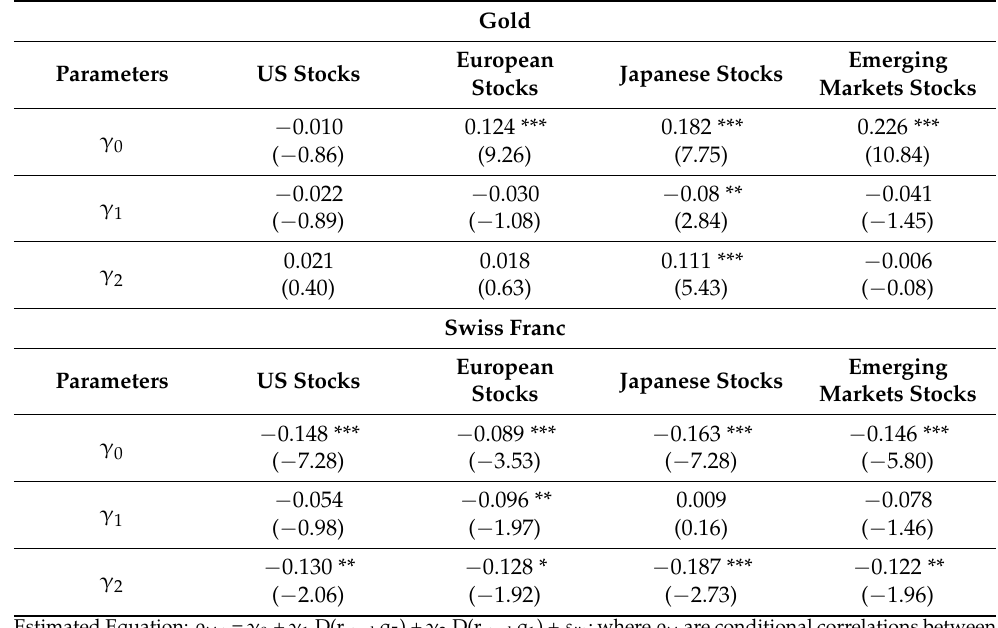
Table 5. Hedge and Safe Haven Properties of Gold and Swiss Franc Under Extreme Negative Stock Market Conditions. Monthly Data: 2000M11–2021M7 (249